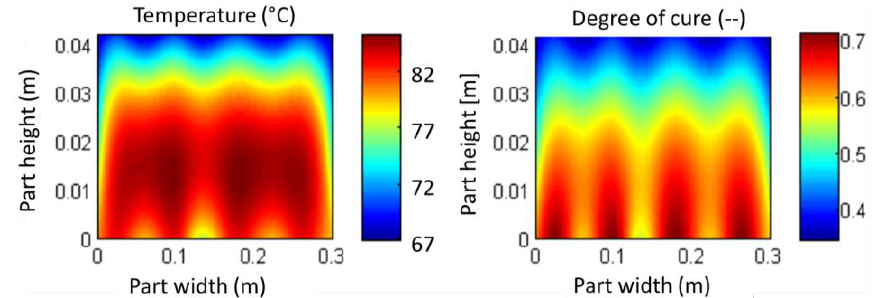
Figure 10. Temperature and curing ration for section A – A after t = 10,640 s.